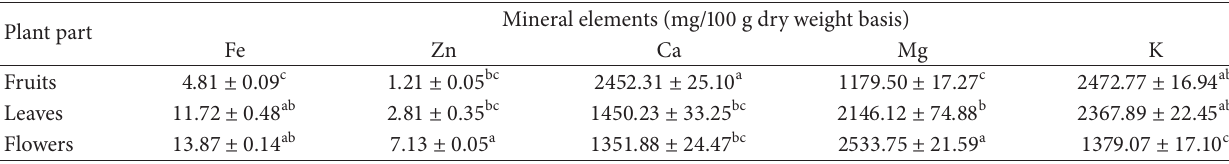
Table 4: Mineral content by microwave assisted digestion.